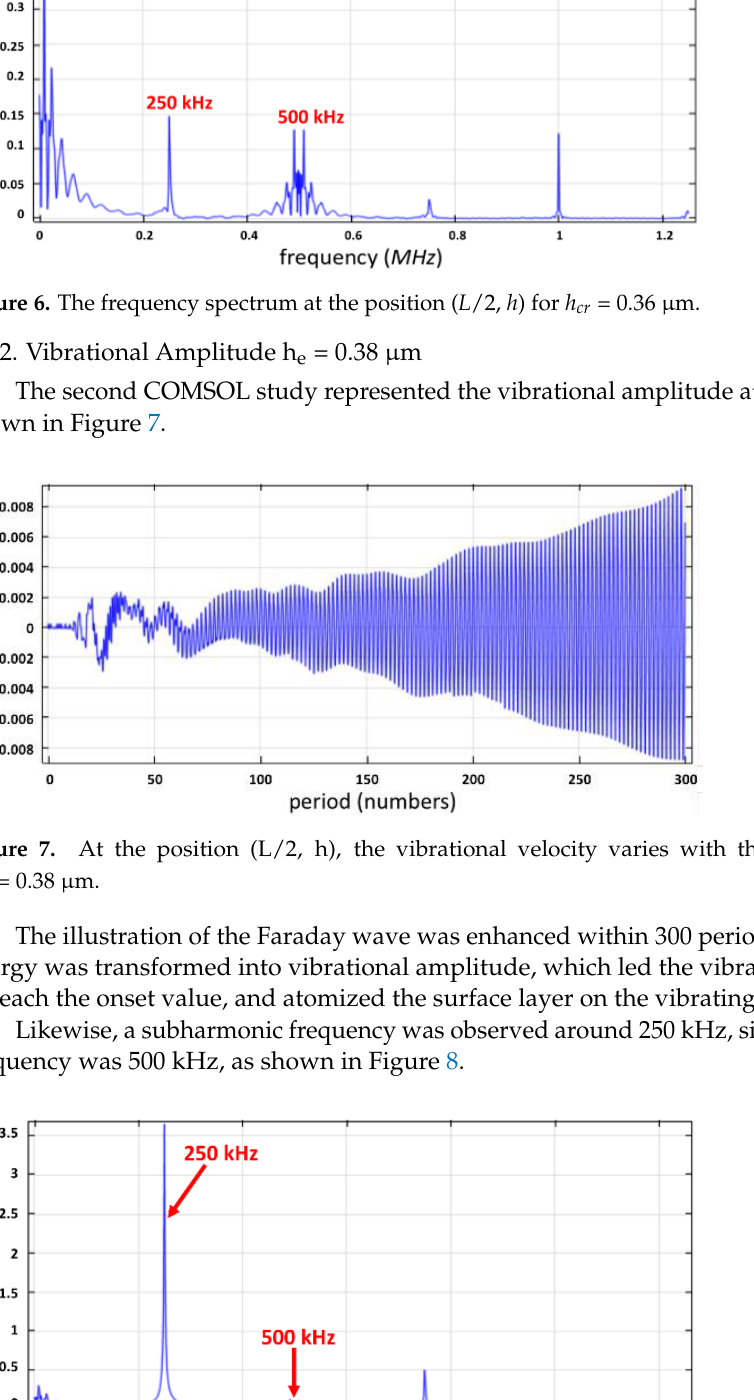
Figure 5. At the position (L/2, h), the vibrational velocity varies with the time period for h cr = 0.36 μ m .